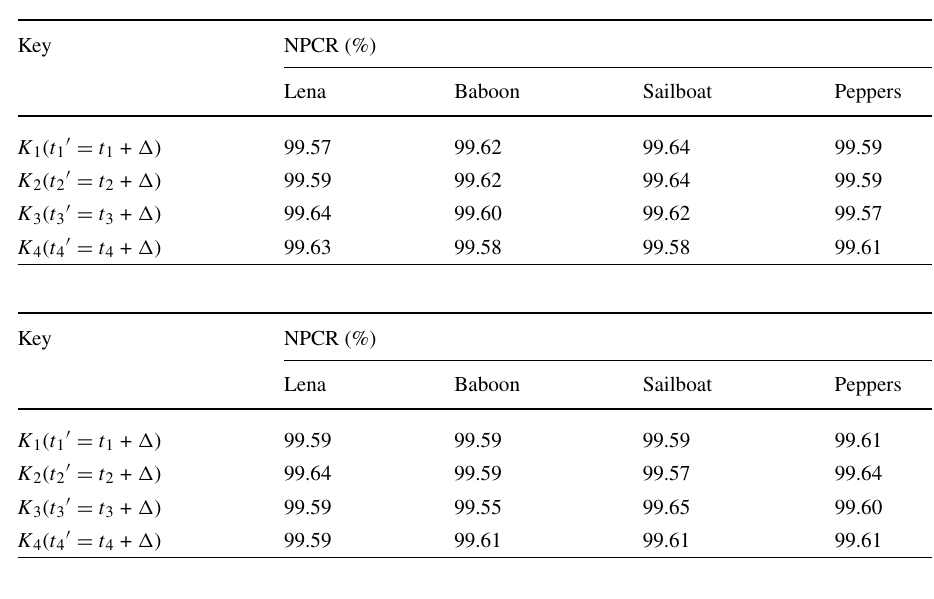
Lena Baboon Sailboat